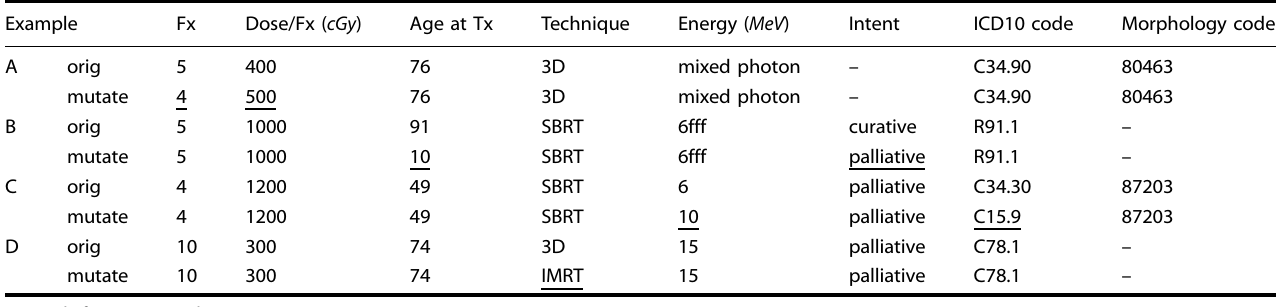
Table 3. Simulated anomaly